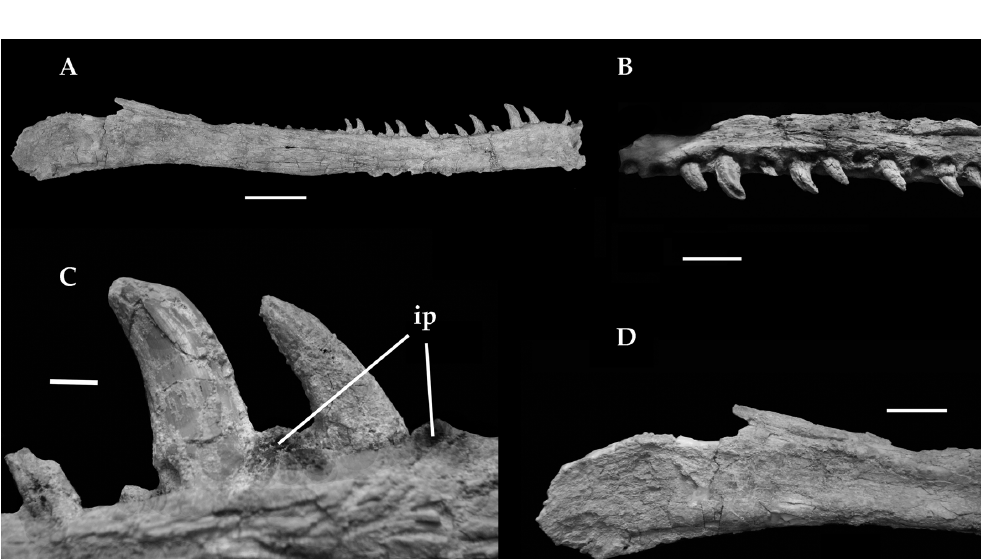
Fig. 2 – Right dentary of Austroraptor cabazai (MML, 195; holotype), A , lateral view of dentary; B , dorsal view of dentary showing anterior alveoli; C , medial view of dentary showing detail of interdental plates; D , posterior end of dentary in lateral view. Scale bar 5 cm. Abbreviations : ip, interdental